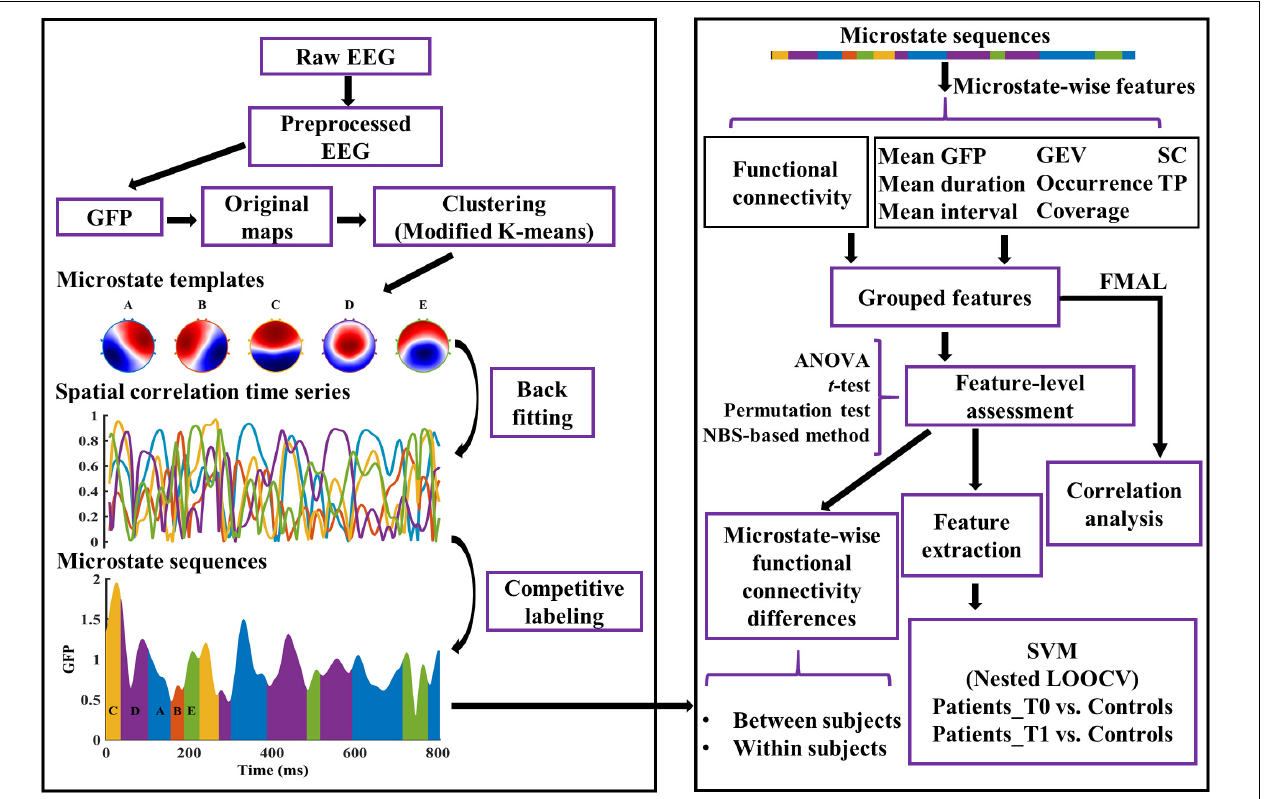
FIGURE 1 | Graphical representation of the analysis method in the study. The microstate templates used in this study are common templates of patients and healthy controls. See “Materials and Methods” section for details. GFP, Global Field Power; GEV, Global Explained Variance; SC, Spatial Correlation metric; TP, Transition Probability; FMAL, Lower-extremity part of Fugl-Meyer Assessment; SVM, Support Vector Machine; LOOCV, Leave-One-Out